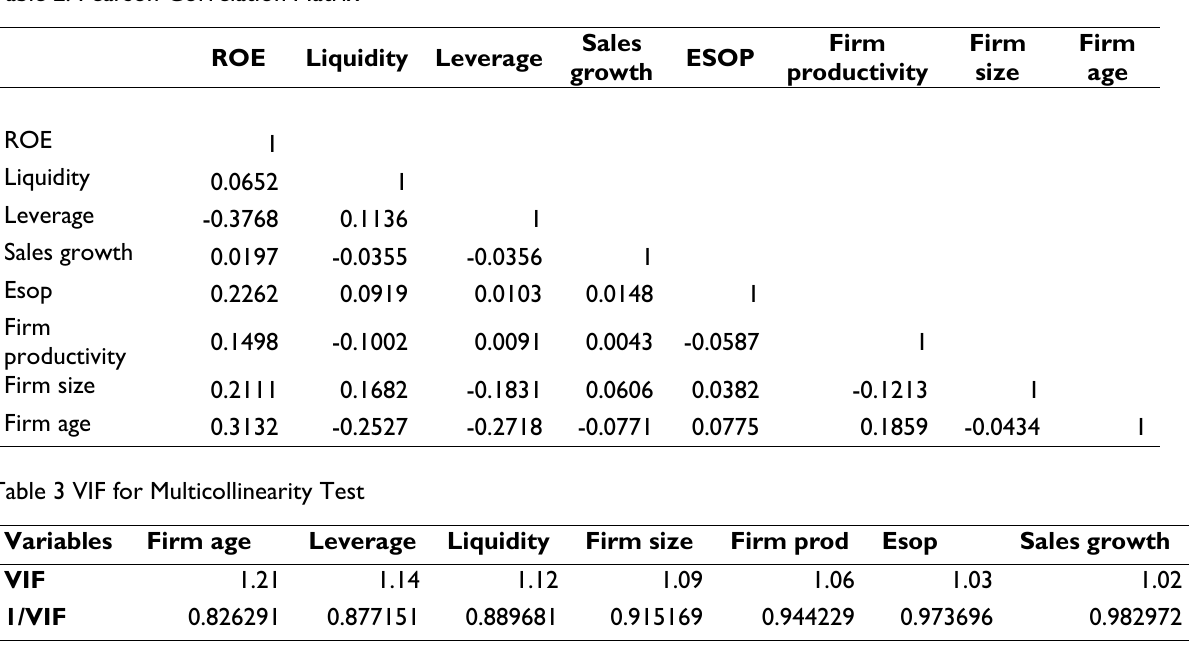
Table 2: Pearson Correlation Matrix